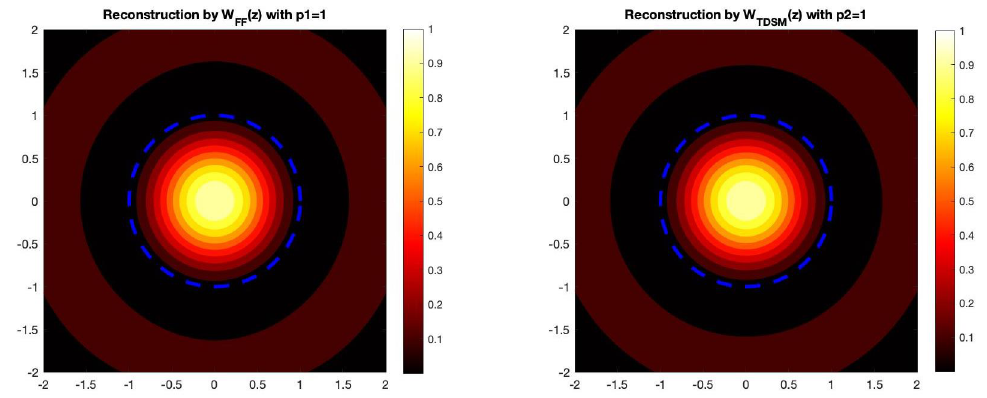
Figure 11. The reconstruction of the unit sphere by the direct sampling imaging functionals. In this example, we take δ = 0.25, which corresponds to a 25% noise level.